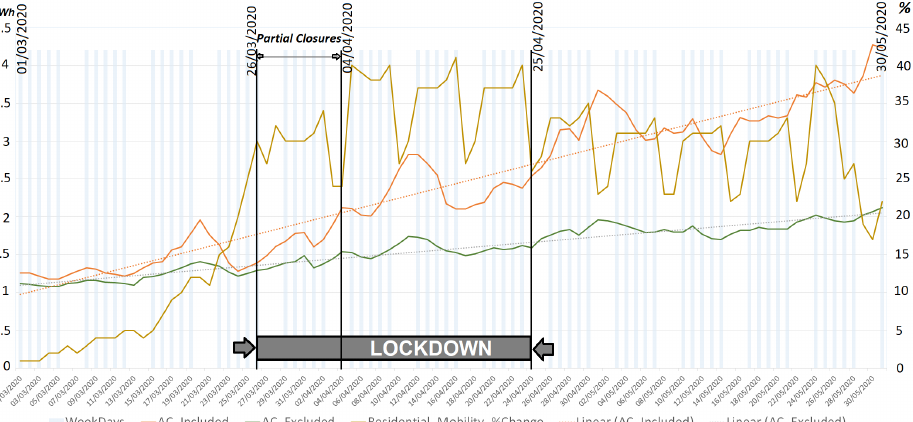
Figure 7. Google mobility chart [36] vs. consumption for AC-included/excluded categories during the lockdown